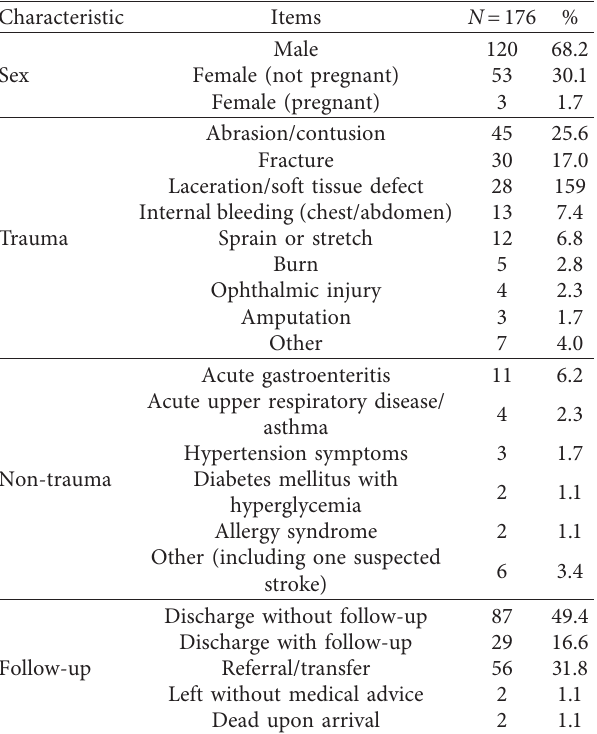
Laceration/soft tissue